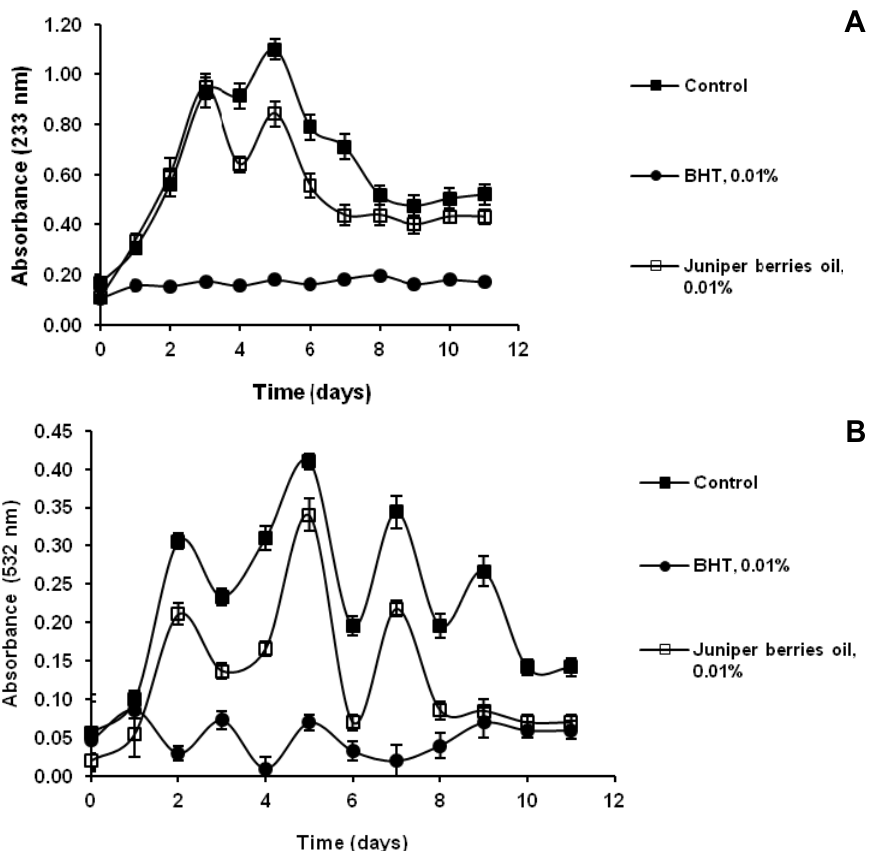
Figure 1. Effect of juniper berry oil on ( A ) conjugated dienes and ( B ) TBARS in a linoleic acid/water emulsion